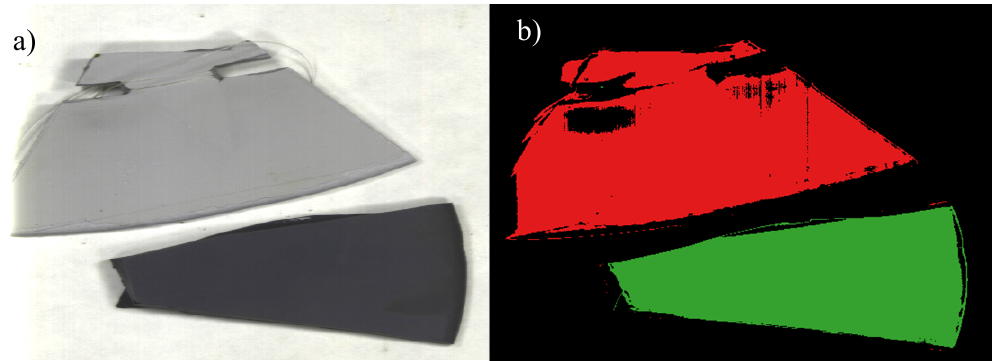
Figure 4. Red Green Blue (RGB) ( a ) and corresponding colormap image ( b ) for virgin (green) and aged (red) high temperature vulcanized (HTV).